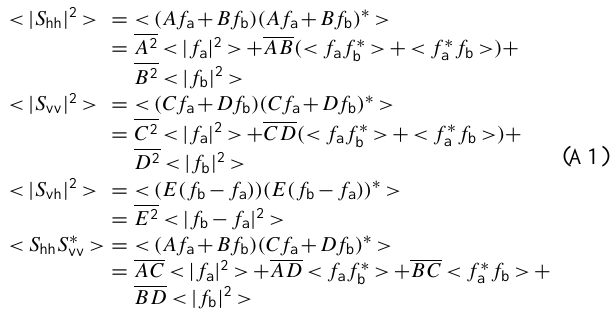
from the NOAA radar and 54.5 km from CSU-CHILL), and the the second one at the University of Colorado’s Platteville (PLT) observatory (27.8 km from the NOAA/ESRL radar and 30.4 km from